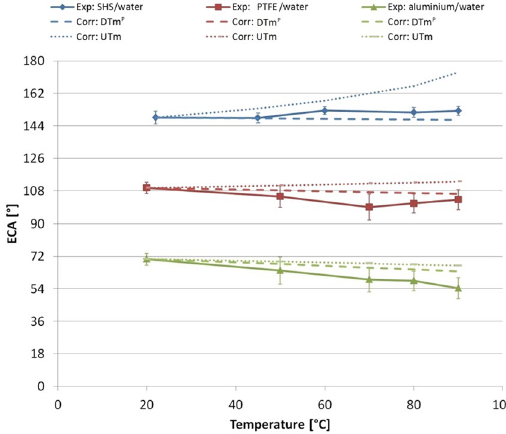
Figure 4. Evaluation of the equilibrium contact angle at different temperatures for a water droplet on SHS (blue) Teflon (red) aluminium (green). The temperature range is 20 °C < T w < 90 °C. The experimental values are compared respectively with the Decreasing Trend Model (DTm P , dashed line) and the Unsymmetrical Trend Model (UTm, dotted line). The parameters of the model are set in order to have the same ECA at 20 °C.